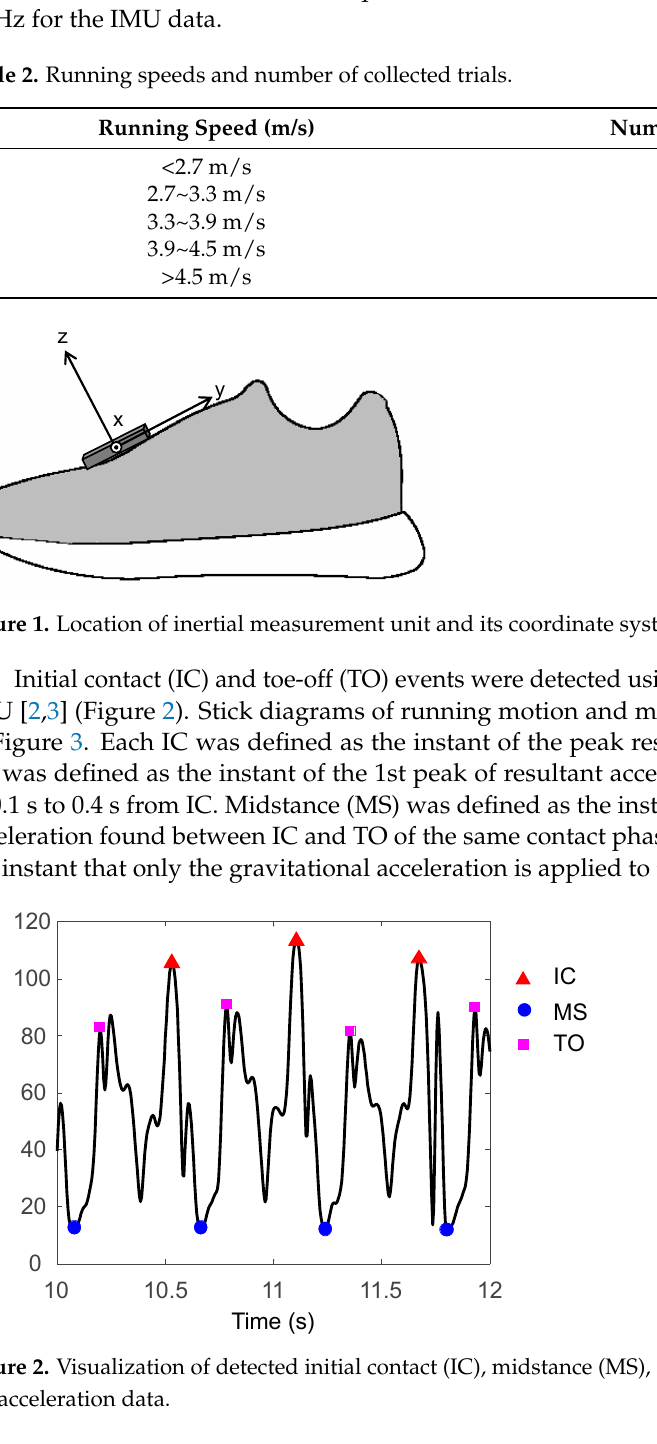
Figure 2. Visualization of detected initial contact (IC), midstance (MS), and toe-off (TO) events using the acceleration